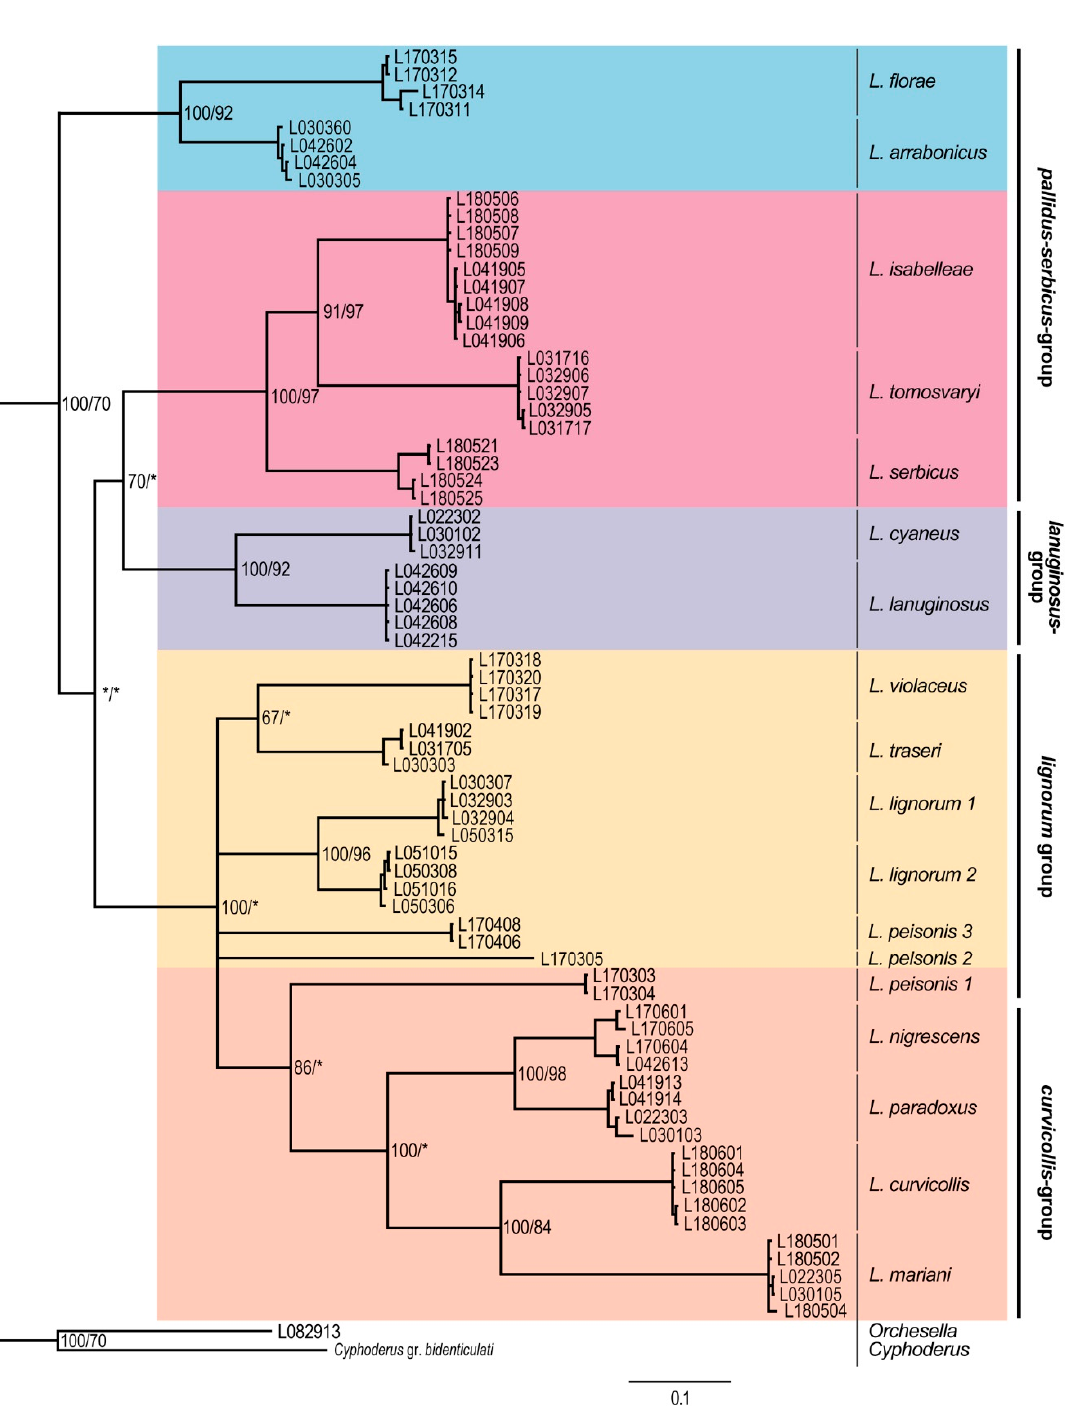
Figure 5. Bayesian consensus tree obtained based on the COII dataset. Numbers close to nodes denote Bayesian posterior probabilities/maximum likelihood bootstrap support. Asterisks (*) indicate posterior probabilities or bootstrap values less than 60%. Morphological groups are labeled in bold.